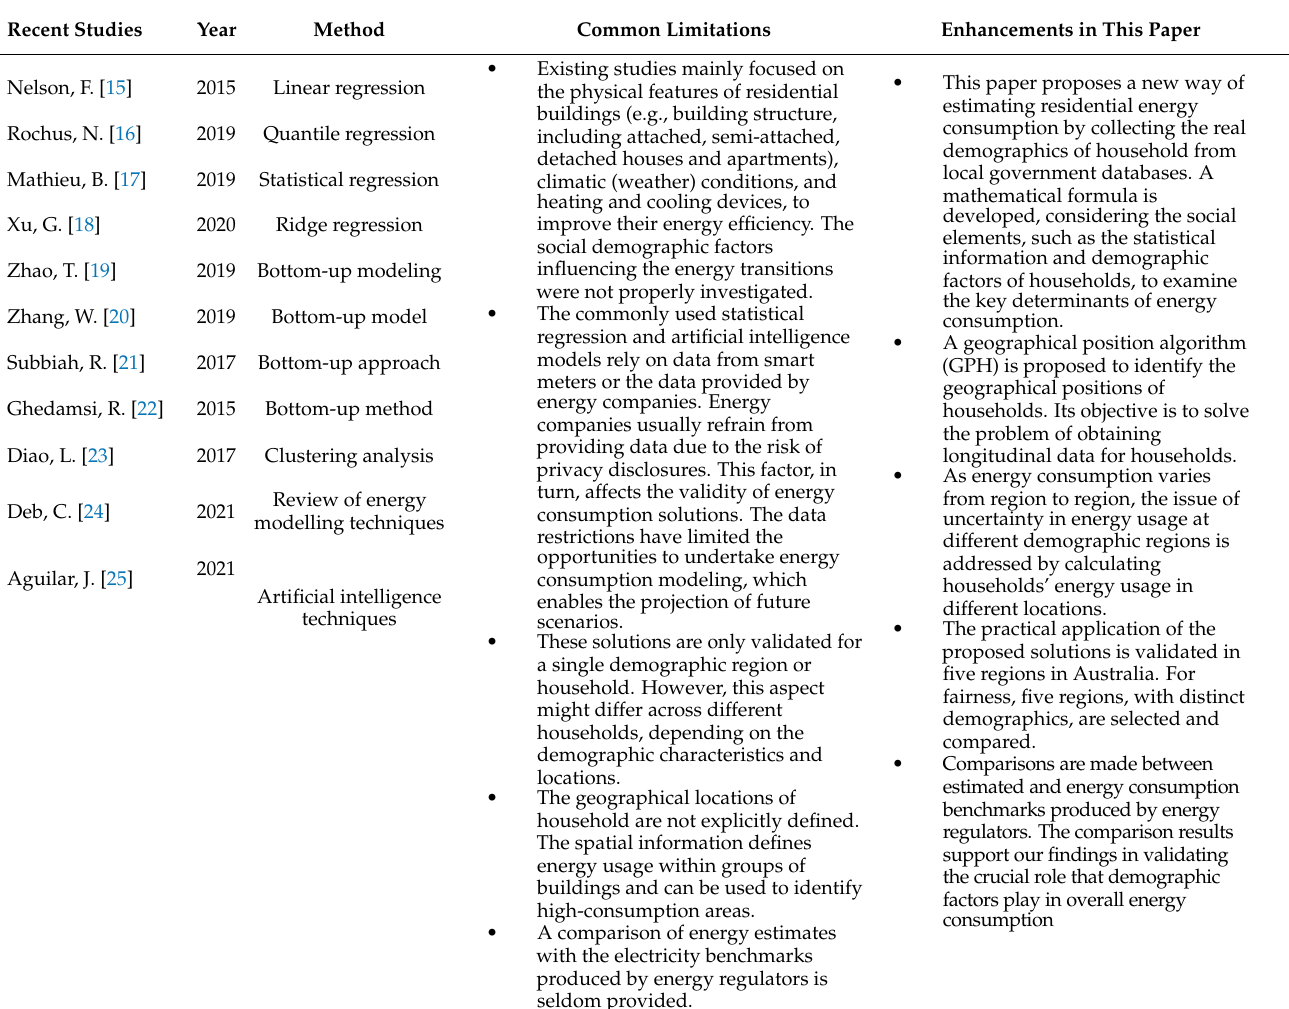
Table 1. Summary of relevant studies in the literature and enhancements in this